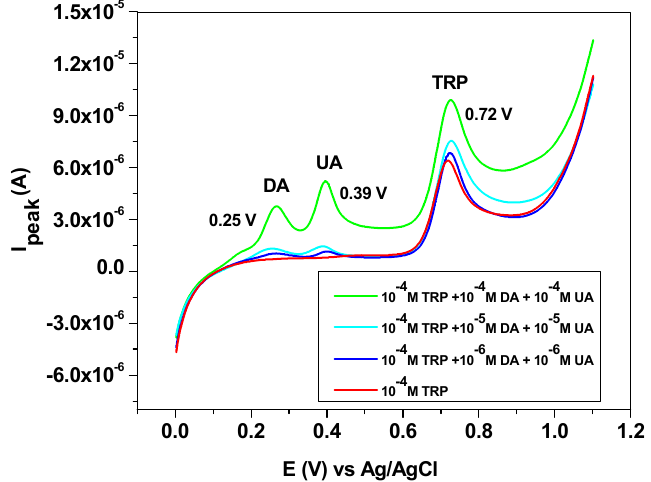
Figure 10. Linear sweep voltammetry (LSV) recorded with the EGr/GC electrode in the absence and presence of interfering species, dopamine, and uric acid. Scan rate: 10 mV/s; supporting electrolyte: pH 6 PBS.